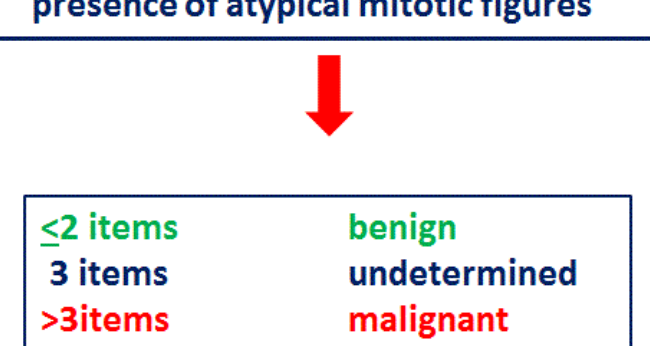
Figure 2. Wieneke Figure 2. Wieneke criteria.